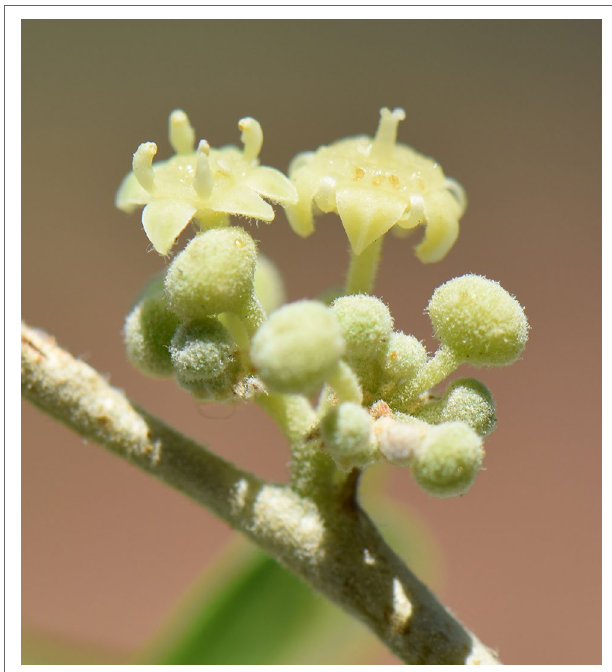
FIGURE 1 | Male-phase (left) and female-phase (right) flowers of Ziziphus spina-christi . Flower diameter is 4–5 mm. Photo: S.